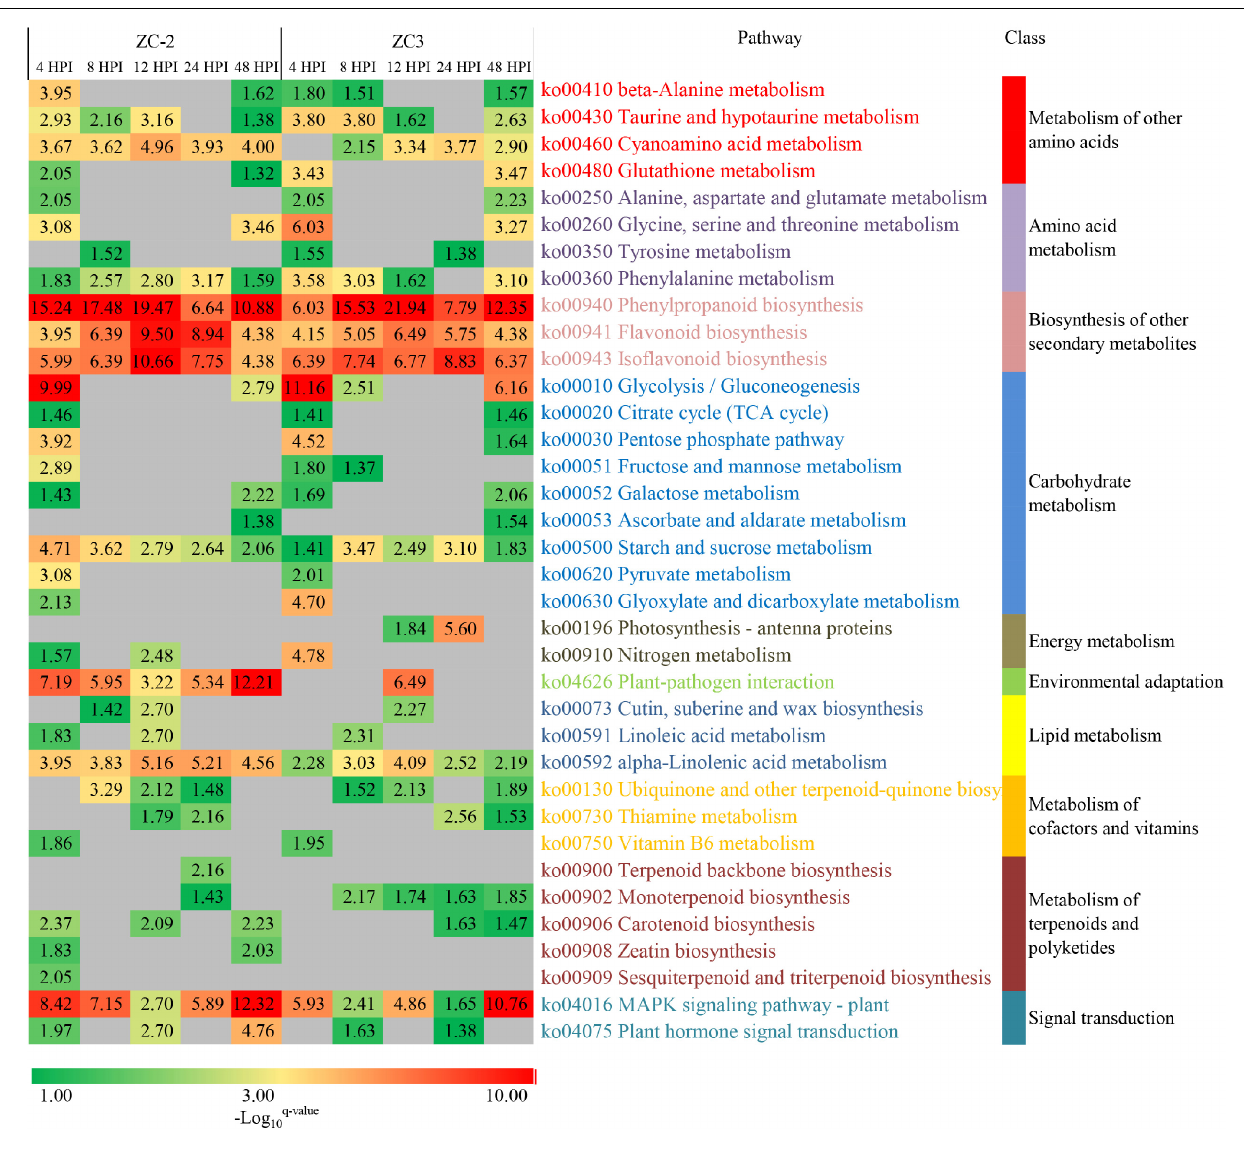
FIGURE 5 | Heatmap of the enriched KEGG pathways in pods of soybean lines ZC-2 and ZC3 infected with Colletotrichum truncatum . The − log 10 q -value is color-coded, from green to red, to indicate low to high degree of enrichment. Each row represents an enriched KEGG pathway; the columns represent each sampling time point [4, 8, 12, 24, and 48 h post-inoculation (HPI)] for ZC-2 and